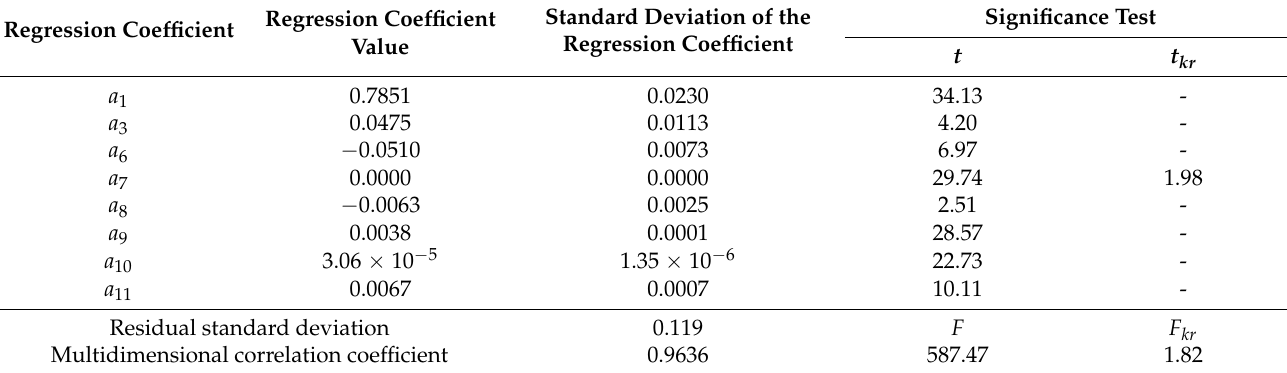
Table 2. The results of the regression function analysis for the machine